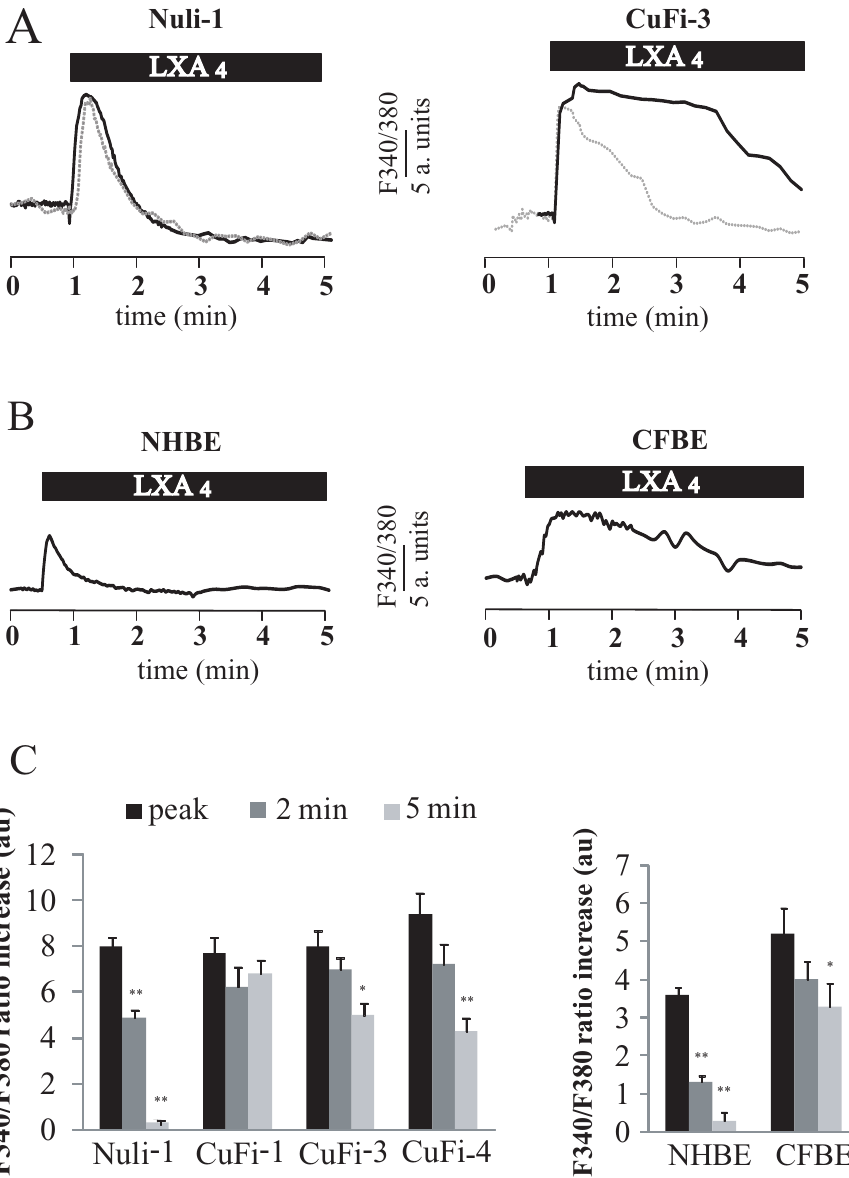
Figure 1. LXA 4 effect on intracellular Ca 2 + activity in non-CF and CF bronchial epithelial cells. (A) Typical effect of LXA 4 (100 nM) on the cytosolic Ca 2 + (ratio F340/F380) measured in Nuli-1 and CuFi-3 cell lines in control (plain line) and in external Ca 2 + -free conditions (dotted line). (B) Typical effect of LXA 4 (100 nM) on the cytosolic Ca 2 + in normal and CF primary cultures of bronchial epithelial cells (NHBE and CFBE). (C) Mean values of the maximum increase in Ca 2 + (peak) and measured 2 and 5 minutes after the peak, in Nuli-1 (n=6), CuFi-1 (n=6), CuFi-3 (n=6), CuFi-4 (n=4) cell lines and in NHBE (n=4) and CFBE (n=4) bronchial epithelial cells in primary culture (* p , 0.05, ** p , 0.01).